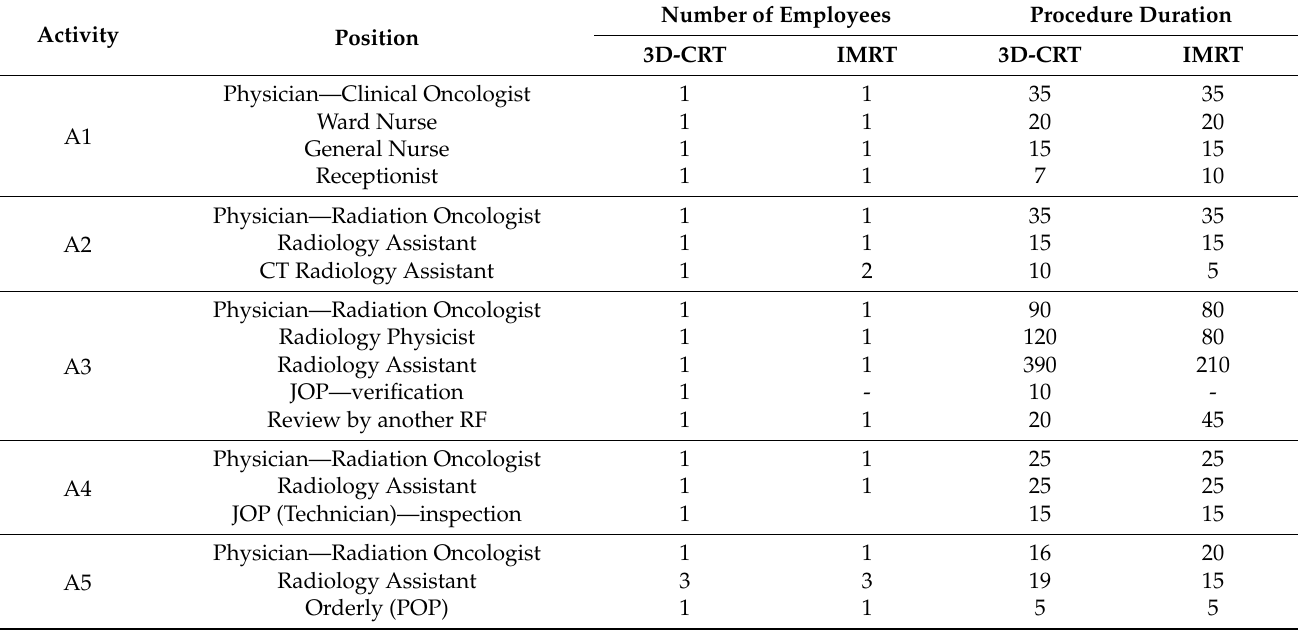
Table 8. Intensity Modulated Radiation (IMR) and Three-Dimensional Conformal Radiation Therapy (3D-CRT) time analysis.